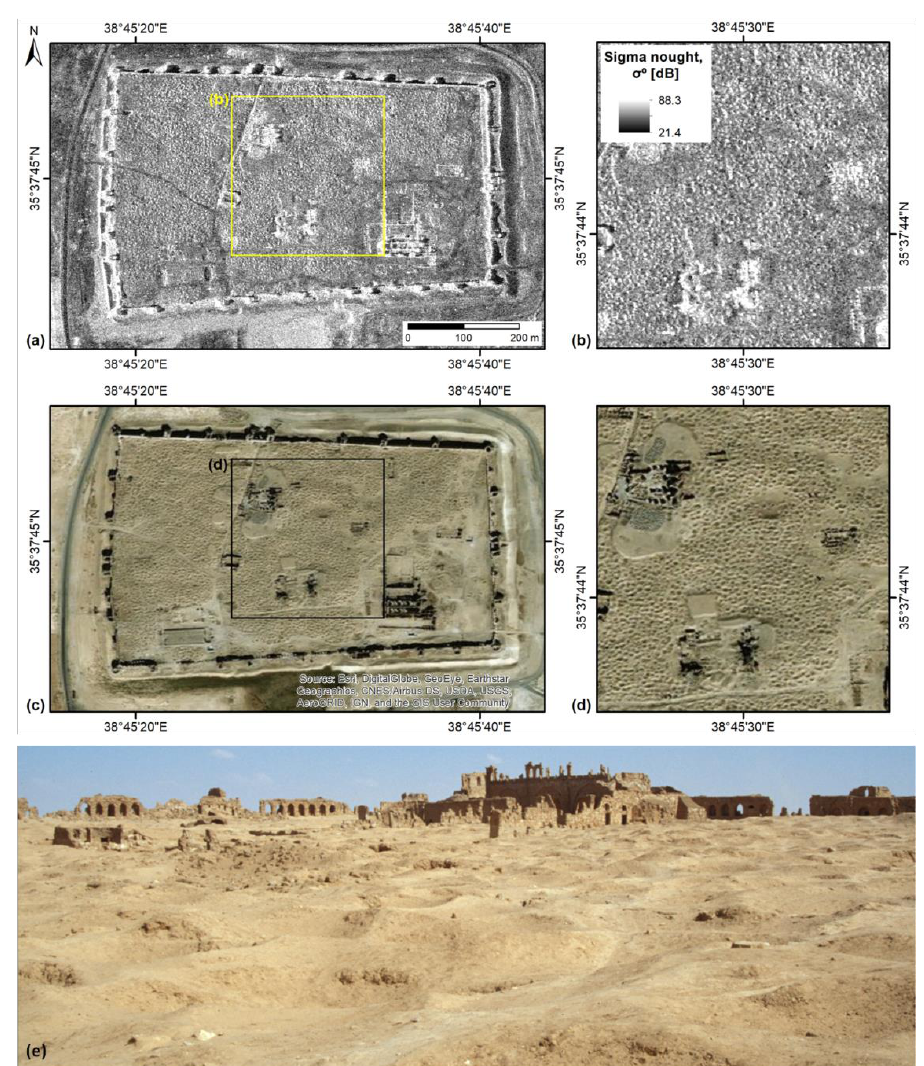
Figure 8. ( a ) Multi-temporal average of 9 COSMO-SkyMed Enhanced Spotlight images acquired between 31/08/2018 and 13/02/2019 at 1-m resolution in ascending mode over the archaeological site of Sergiopolis, Resafa (Syria), showing the extensive looting that took place prior to the Syrian civil war. ( b ) Zoomed view of the central area highlighting the density and circular concave shape of looting features, which match with evidence from ( c–d ) ArcGIS basemap image 05/10/2014 and ( e ) ground-truth photograph taken on 06/05/2000 (credit/courtesy: M.C.C. and M.C.). COSMO-SkyMed ® Products © ASI—Italian Space Agency—2018–2019. All Rights Reserved.